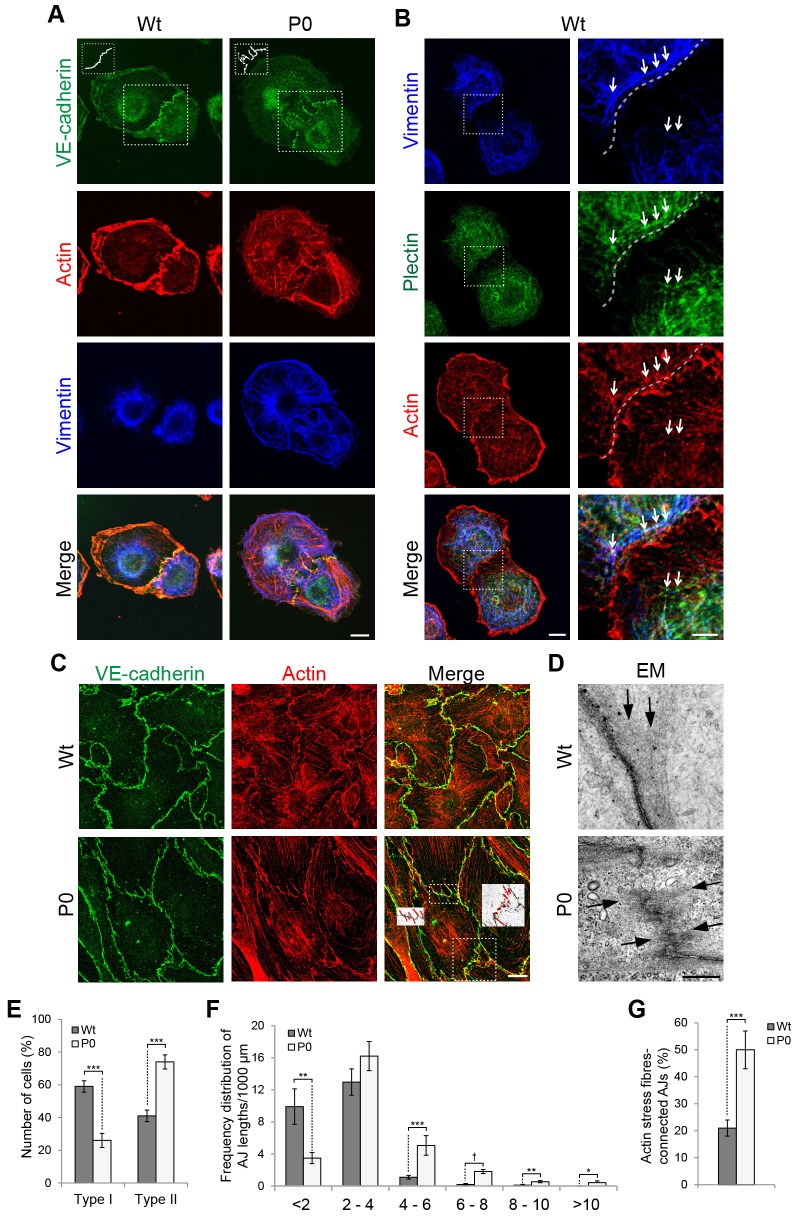
Distortions of cell–cell junctional VE-cadherin in the absence of plectin. (A) Triple immunolabelling of primary Wt and P0 cells using antibodies to VE-cadherin, actin and vimentin. To better visualize differences between Wt and mutant AJs, a free-hand reconstruction of VE-cadherin-marked cell–cell borders within the boxed areas is shown in insets in the upper left corner of the images in the top row. Scale bar: 10 µm. (B) Maximum intensity projection of confocal z-stacks after triple immunolabelling of primary Wt cells using antibodies to vimentin, plectin and actin (pseudocolours). Dashed boxes, cell–cell border regions shown enlarged in right panels. Dashed line, cell–cell border. Arrows, plectin patches aligning along vimentin filaments and partially colocalizing with actin patches. Scale bars: 10 µm (left column); 5 µm (right column). (C) Immunolabelling of confluent cell layers (∼24 h adhesion) formed from Wt and P0 endothelial cells using antibodies to VE-cadherin and actin. Areas with representative AJ distortions (spikes) in plectin-deficient cells are boxed (merged image). Black-and-white insets of the boxed regions show outlined (in red) VE-cadherin-positive spikes. Outlined structures were processed in ImageJ for length measurements; all marked structures were additionally scored for association with actin stress fibres (see G). Scale bar: 10 µm. (D) Transmission electron microscopy of endothelial cell–cell junctions in monolayer cultures of Wt and P0 endothelial cell lines. Arrows, actin stress fibres. Scale bar: 500 nm. (E) Percentage of primary cells (in randomly chosen optical fields) displaying pronounced cortical actin along AJs and sparse actin stress fibres (type I) versus cells lacking cortical actin along AJs but displaying pronounced actin stress fibres (type II); representative examples are shown in A. Results are mean±s.e.m. from five independent experiments, in total ∼350 cells. (F) Frequency distribution of AJ lengths per 1000 µm. Results are mean±s.e.m. (>900 junctions were measured per genotype from three independent experiments). (G) Junctions distinguished by actin stress fibres connections were counted in randomly chosen optical fields and their proportion of total junctions counted was determined for each genotype. Results are mean±s.e.m. (>90 junctions from three independent experiments). *P<0.05, **P<0.01, ***P<0.001, †P<0.0001 (Student's t-test).